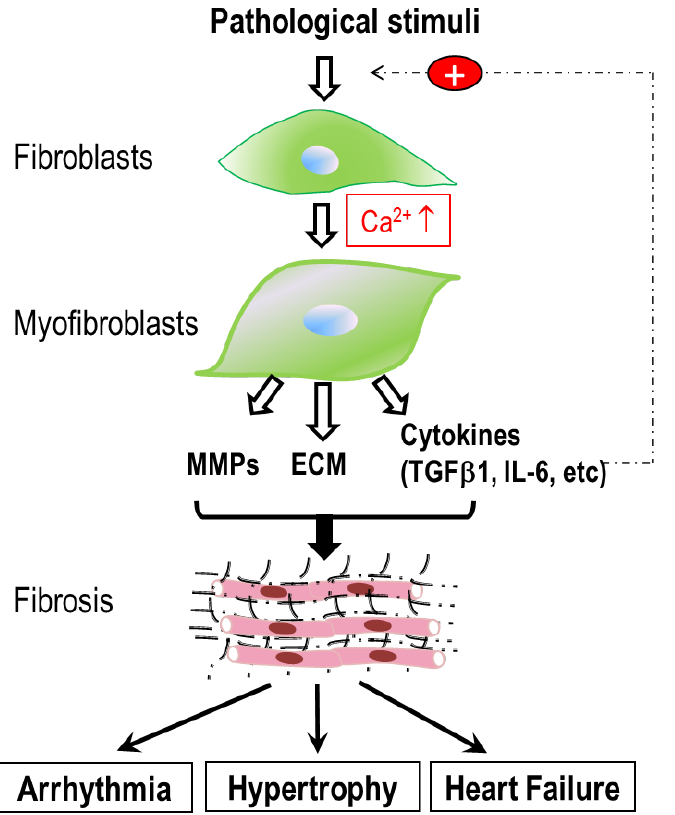
Figure 1. Schematic diagram illustrating cardiac fibrogenesis cascade and fibrosis-associated heart diseases. Pathological stresses stimulate fibroblasts to differentiate into myofibroblasts, during which an increase in intracellular Ca 2 + plays a key role. Myofibroblasts synthesize and secrete extracellular matrix (ECM) proteins, matrix metalloproteinases (MMPs), and cytokines such as TGF β 1. Excessive deposition of ECM proteins results in cardiac fibrosis. This fibrogenesis cascade is perpetuated by TGF β 1 produced by myofibroblasts. Cardiac fibrosis is involved in a variety of pathological remodeling, which can lead to arrhythmia, hypertrophy and heart failure.